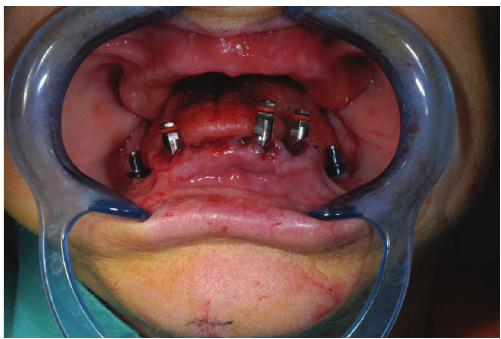
Figure 4: Implants positioned in the mandible.